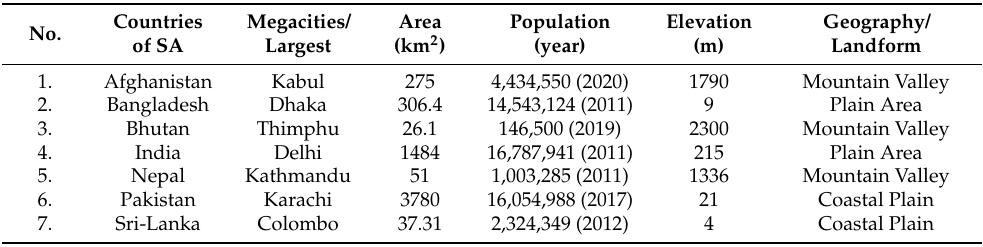
Table 1. Study Area Cities Details (Source: World Atlas